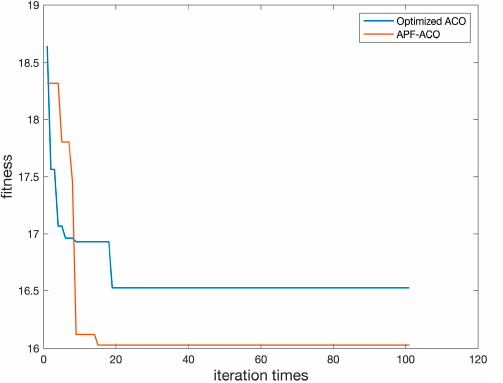
Figure 13. Comparison of Convergence Speed of APF-ACO and Optimized ACO Algorithms.